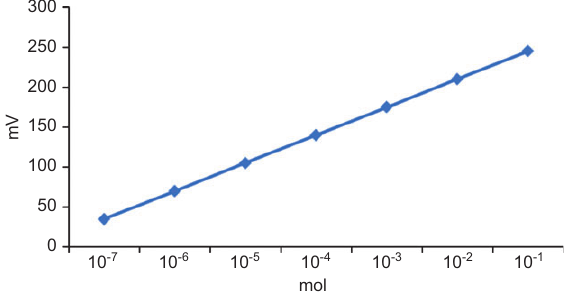
Figure 1 Copper metal sensors ’